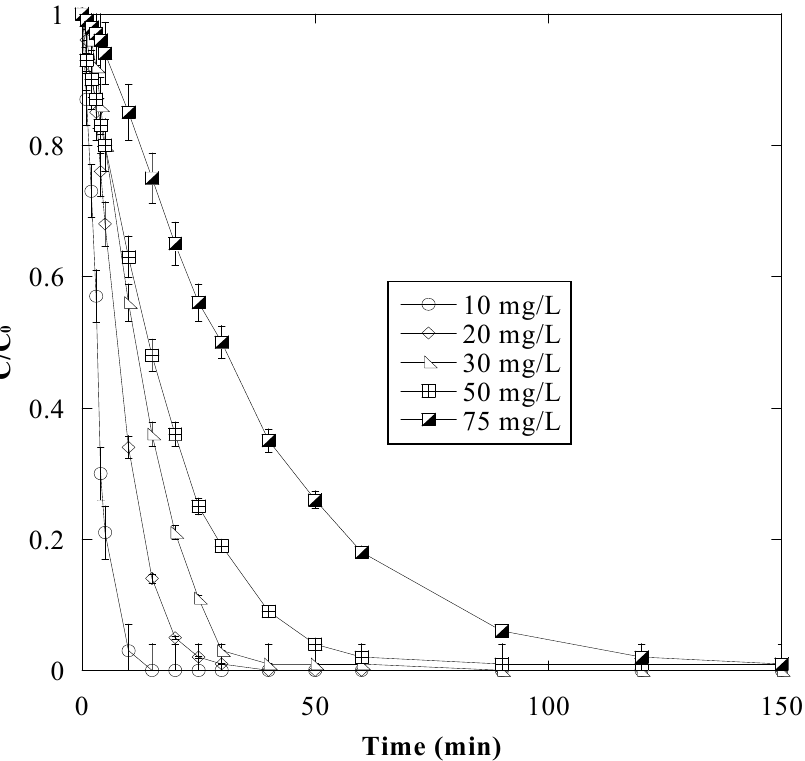
Figure 7. Effect of initial AO10 concentration on its degradation ([A010] 0 = 10–75 mg/L, 20 ± 1 °C, [IO 4 − ] = 3 mM, initial pH 5.4, irradiation intensity: 15 mW/cm 2 ). The plot of initial degradation rate (r 0 , calculated from Figure 7) vs. initial AO10 concentration, C 0 , (Figure 8) clearly shows a non-linear relation between r 0 and C 0 , which excludes the validity of first order kinetic law for the degradation of AO10. In fact,